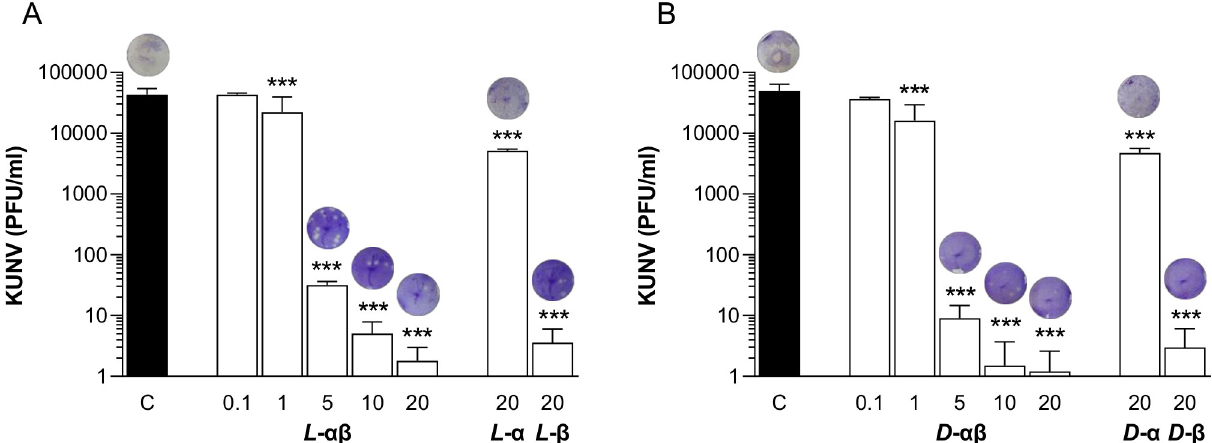
Fig 4. Both L- and D-enantiomers of PLNC8 αβ are effective against WNV Kunjin . The flavivirus Kunjin (KUNV, 1 × 10 5 ), suspended in DMEM, was exposed to A - L-enantiomer or B - D-enantiomer of PLNC8 α or PLNC8 β at a final concentration of 20 μ M or PLNC8 αβ (molar ratio 1:1) at a final concentration of 0.1, 1, 5, 10 and 20 μ M for 1 h at 37˚C. The suspension was then added to Vero cells and incubated for 1 h, followed by quantification of the viral load by performing crystal violet-based plaque assay. The indicated concentrations are in μ M. Representative images of the virus plaques are presented above the bars. The virus particles are rapidly permeabilized by both enantiomers of PLNC8 αβ that decreased the viral load by > 99.9%. The data (n = 3) are presented as mean with SEM and analysed using one-way ANOVA with Dunnett´s multiple comparison test ( ��� p < 0.001).